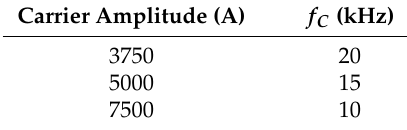
Figure 10. ( a ) Software-OCC. ( b ) Phase-current conditioner. Table 1. Carrier Amplitude and frequency for DSP